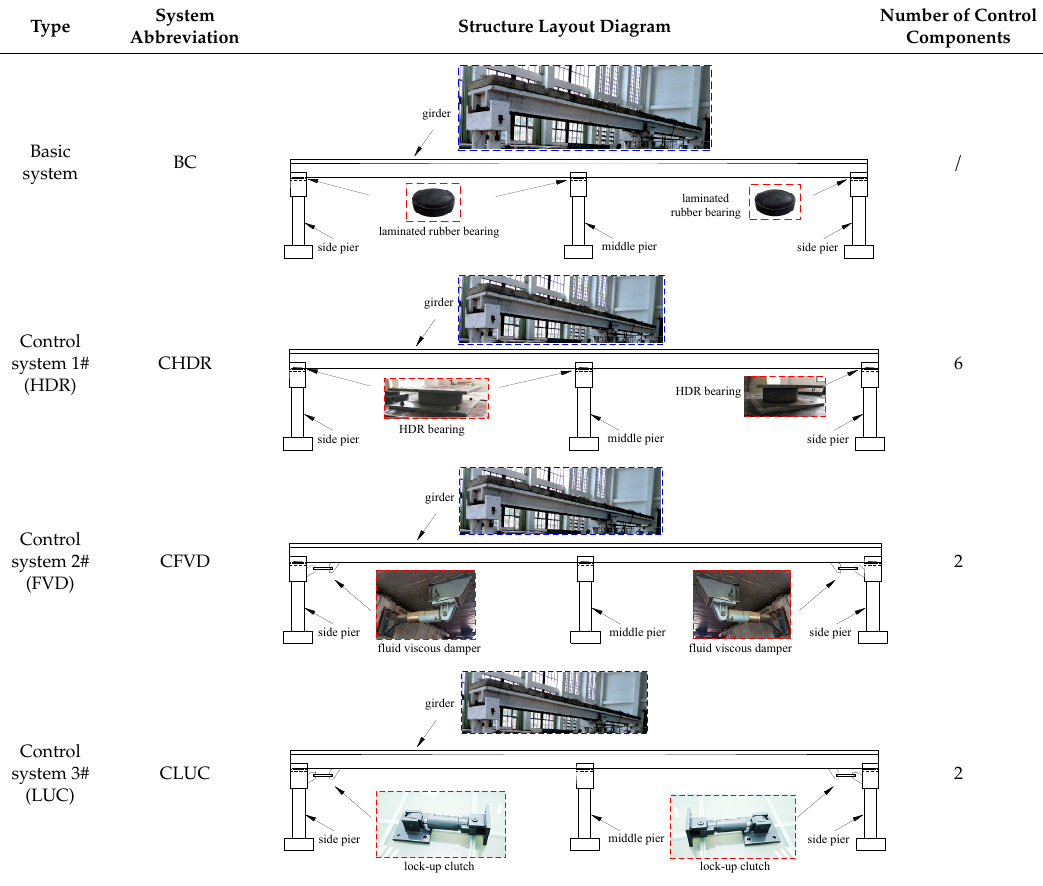
Table 1. Layout Information of Bridge Systems. BC: XXX; CHDR: XXX; CFVD: XXX; CLUC: XXX.